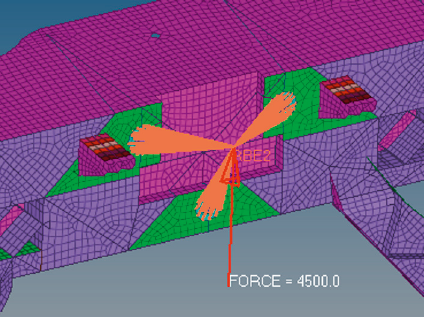
Figure 18: Engine lock load setting.